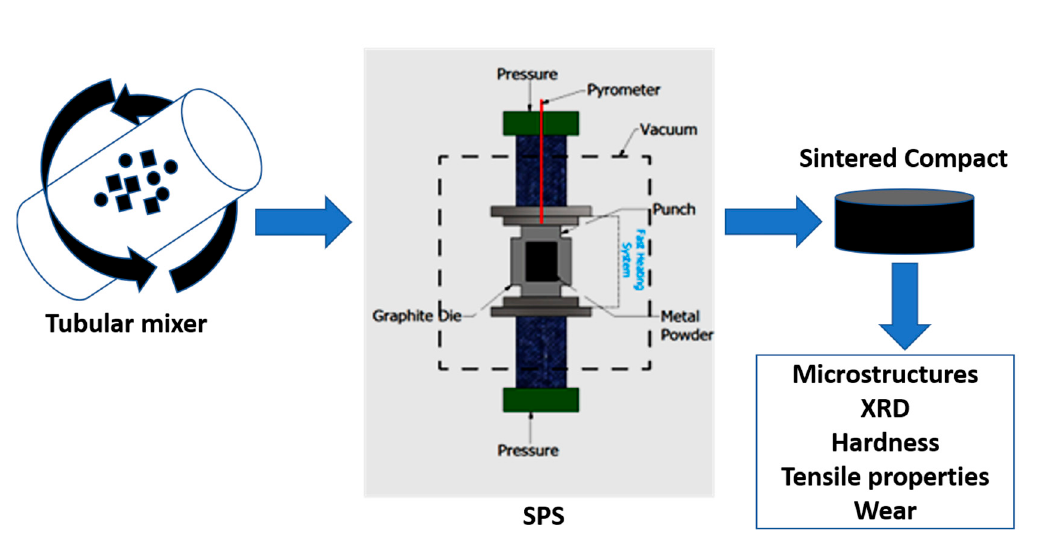
Figure 1. Graphical illustration of the experiment.